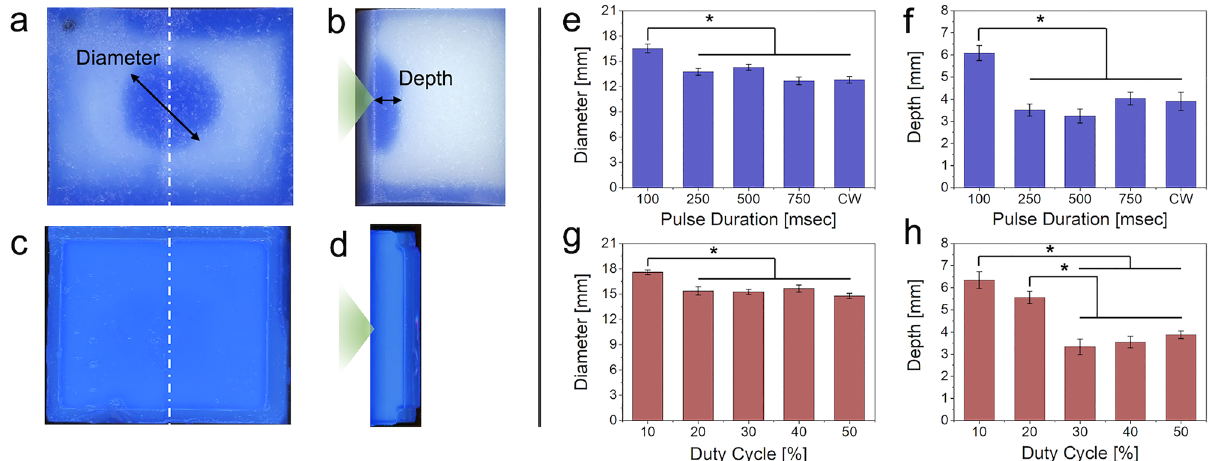
Figure 2. Results from the dye infiltration test. ( a ) Exemplary front view of a melamine foam showing dye infiltration and ( b ) the middle section (dashed line from the front view) showing the dye infiltration depth. The green triangle depicts the direction of sonication. ( c ) Front view and ( d ) the section view of an exemplar agar block that does not show sonication-related dye infiltration. The effects of different pulse durations (PDs in ms; CW = continuous wave) on ( e ) infiltration inlet diameter and ( f ) depth. The effect of FUS given at 100 ms PD with a DC of 10% on the ( g ) inlet diameter and ( h ) depth of TbO infiltration. I SPTA was maintained at 0.5 W/cm 2 throughout the conditions. Error bar: standard error. *post-hoc Tukey HSD, P < 0.001 following